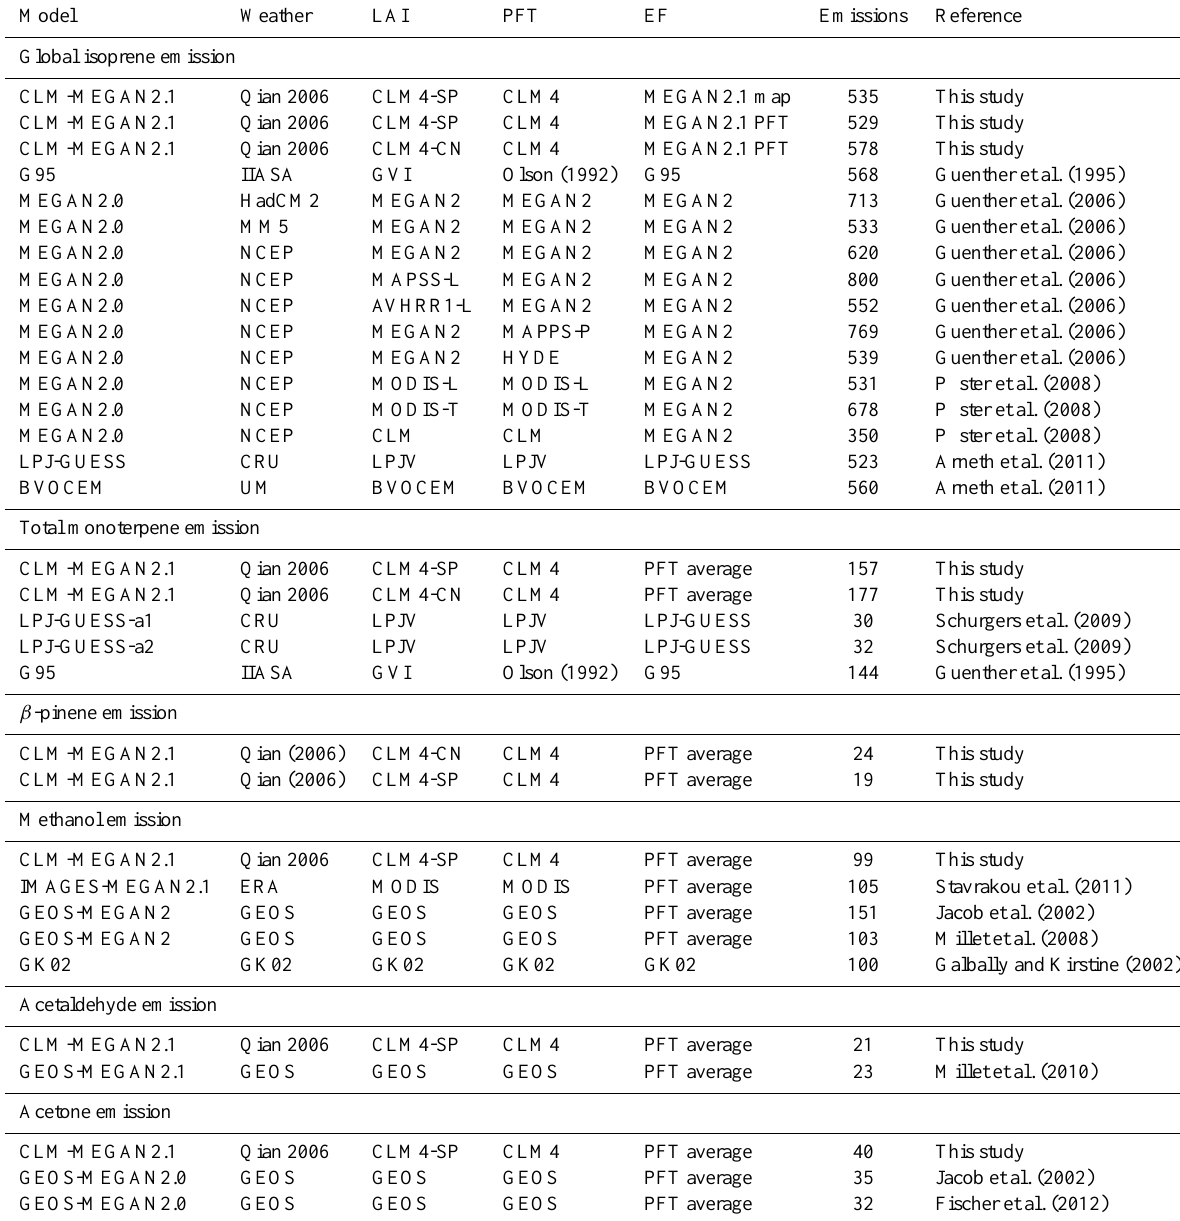
Table 5. Comparison of global annual emissions estimates (Tgyr − 1